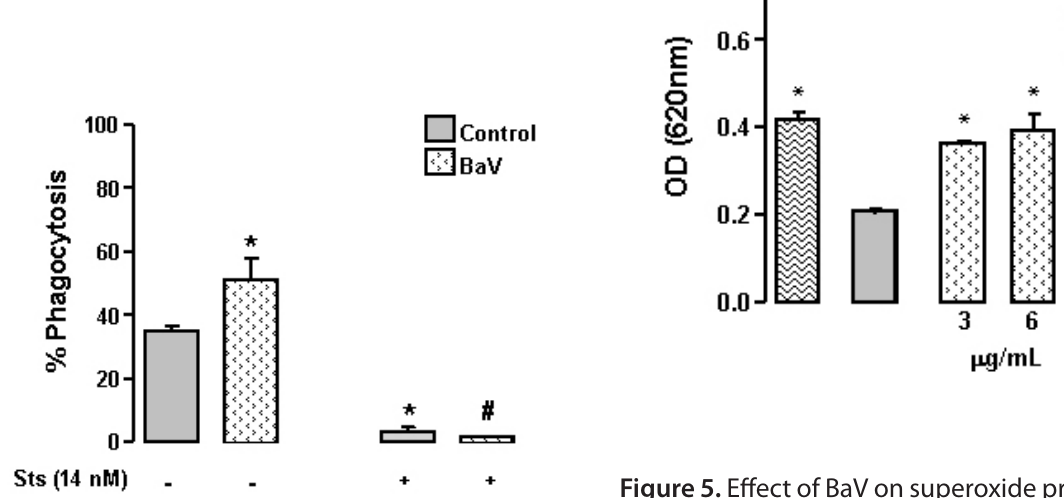
Figure 5. Effect of BaV on superoxide production by thioglycollate-elicited macrophages. Thioglycollate - elicited macrophages harvested 96 hours after intraperitoneal thioglycollate injection were incubated for one hour with RPMI, 0.1% NBT, 10 mL of PMA (500 ng/mL) (positive control), BaV (3 and 6 μg/mL) for the formation of formazan crystals resulting from the reduction of NBT by superoxide. The crystals were solubilized and supernatant absorbance determined at 620 nm in a spectrophotometer. Data were expressed as OD. Values are mean ± SEM from four animals. * p < 0.05 compared to controls